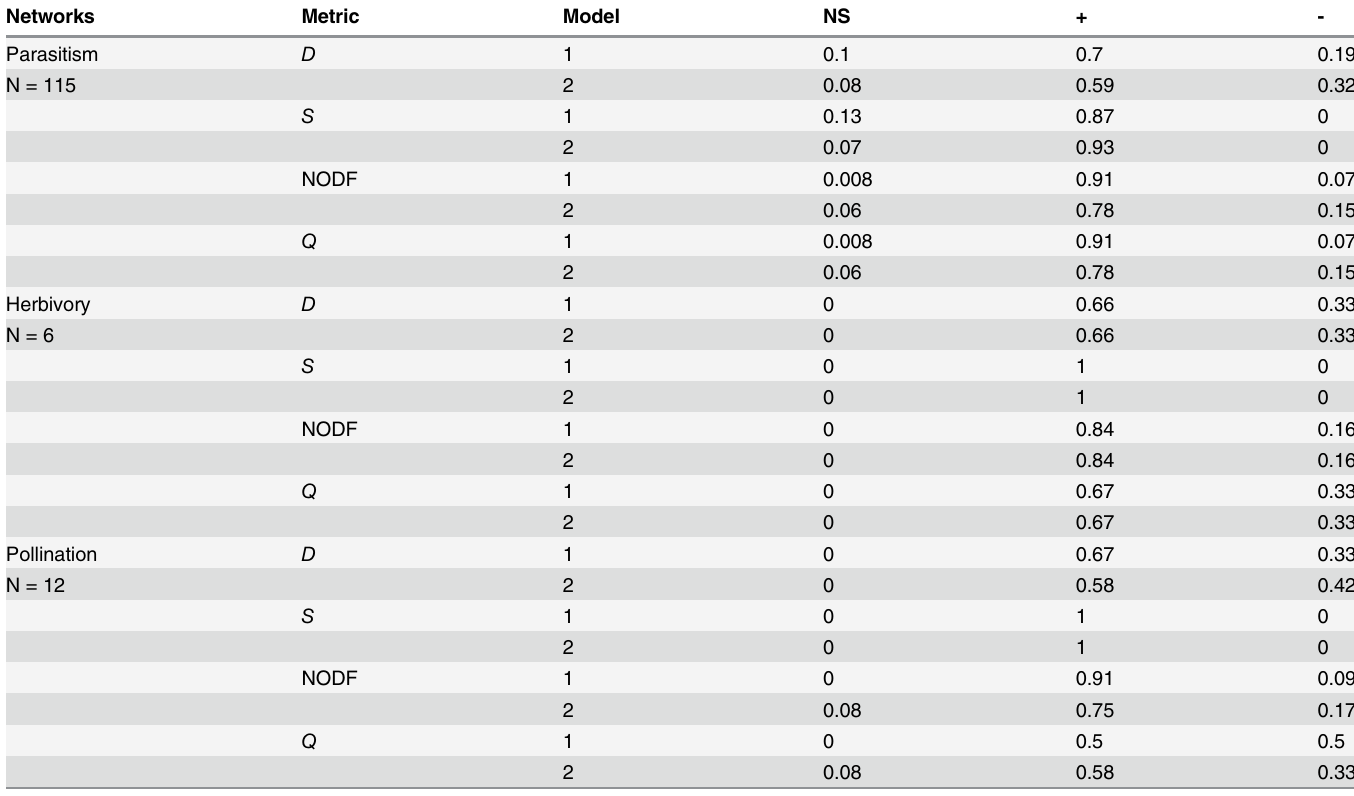
Table 1. Results of the null models analyses. For each network metric, and for each null model, we indicate the proportion of networks that had significantly larger or smaller values than expected by chance. A network has a significantly different value from the prediction when the empirical value falls outside of the 95% confidence interval for the value as measured on randomized networks